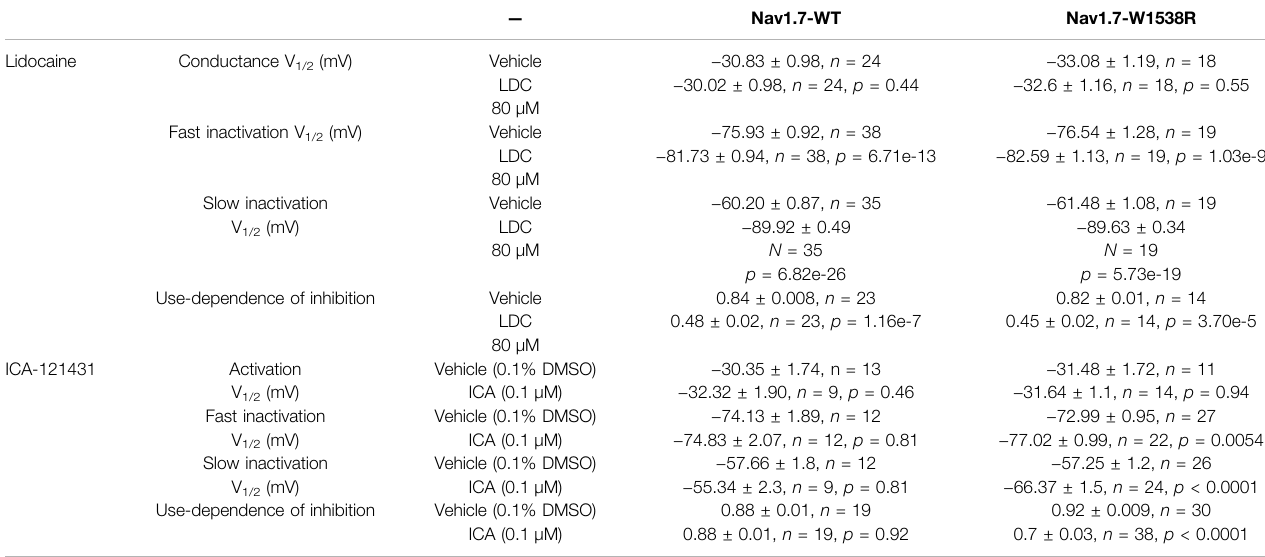
TABLE 2 | - Inhibitory effects of sodium channel blockers Lidocaine (LDC) and ICA-121431 on NaV1.7-WT and W1538R mutant channels. Lidocaine blocked both Na V 1.7 WTandW1538Rchannels,byhyperpolarizingfastandslowinactivationaswellasincreasinguse-dependenceinhibition.Na V 1.3-selectiveblockerICA-121431potently inhibited Na V 1.7-W1538R mutant channels whilehaving no effect on Na V 1.7-WT channels. Treatment with ICA-121431 caused a hyperpolarizing shift in both fast and slow inactivationandincreaseduse-dependentblockofW1538Rmutantchannels.Likefor300 μ Mlacosamide,80 μ Mlidocaine-inducedshiftinslowinactivationofbothNa v 1.7- WT and W1538R channels was best fi tted by a double Boltzmann, hence the fi rst V 1/2 of the fi t is reported in the table below, while vehicle was best fi tted to a single Boltzmann. Data are presented as Means ±